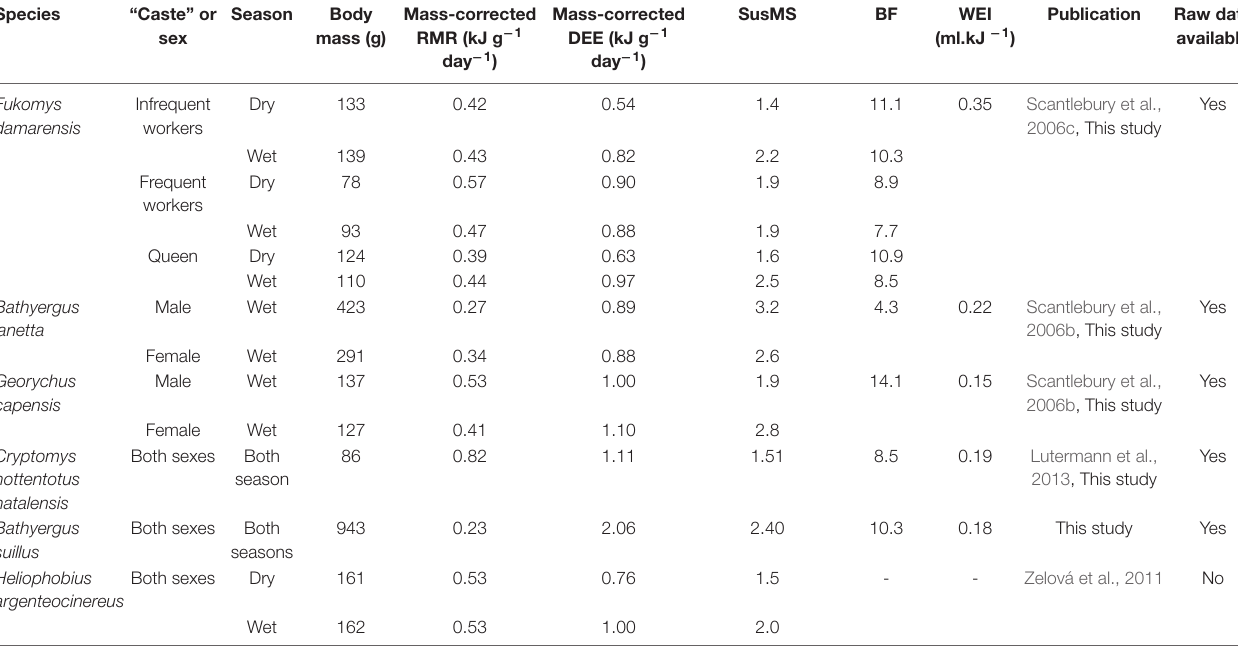
TABLE 1 | Overview of previously published and original data that utilized the DEE methodology on various African mole-rat species. Species “Caste” or sex